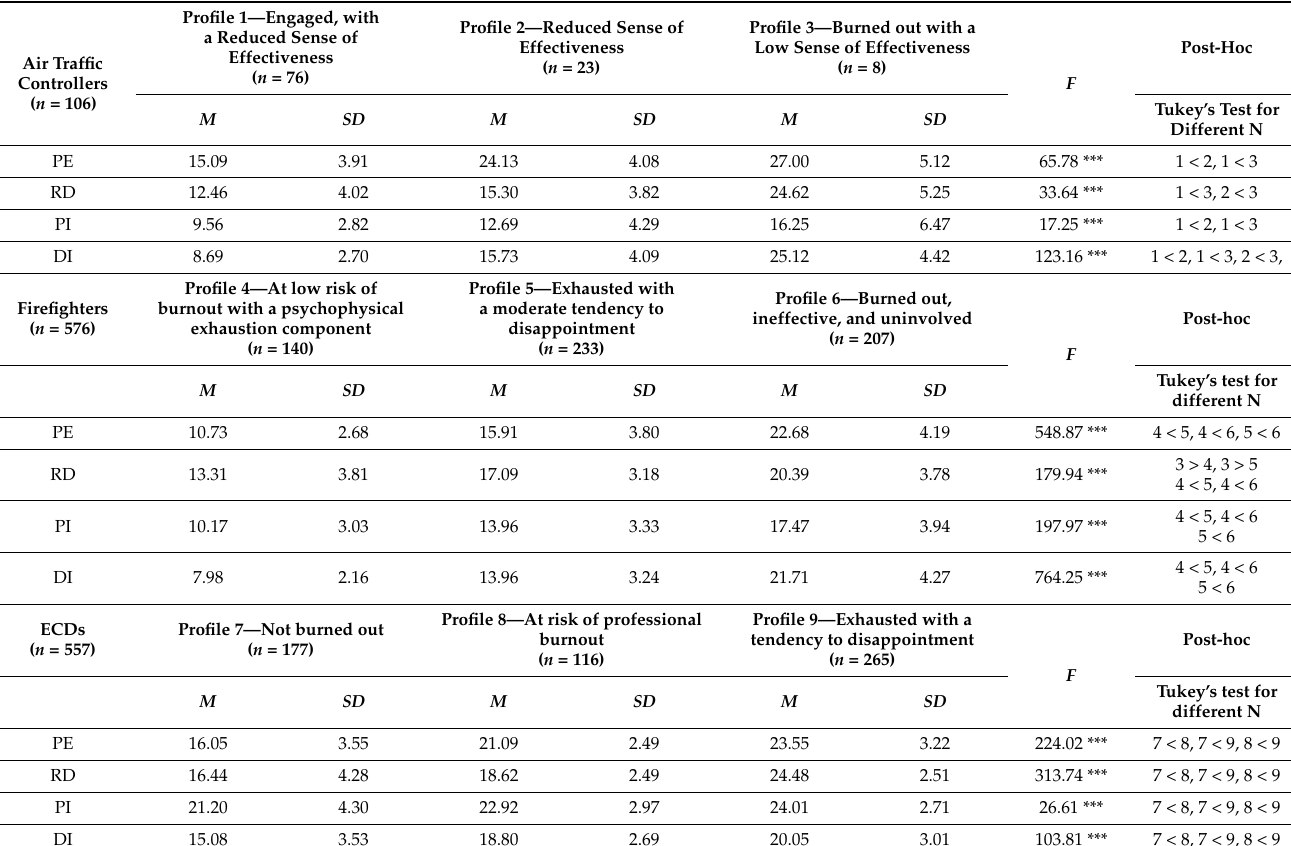
Table 4. Characteristics of the profiles identified in the groups of representatives of high-risk